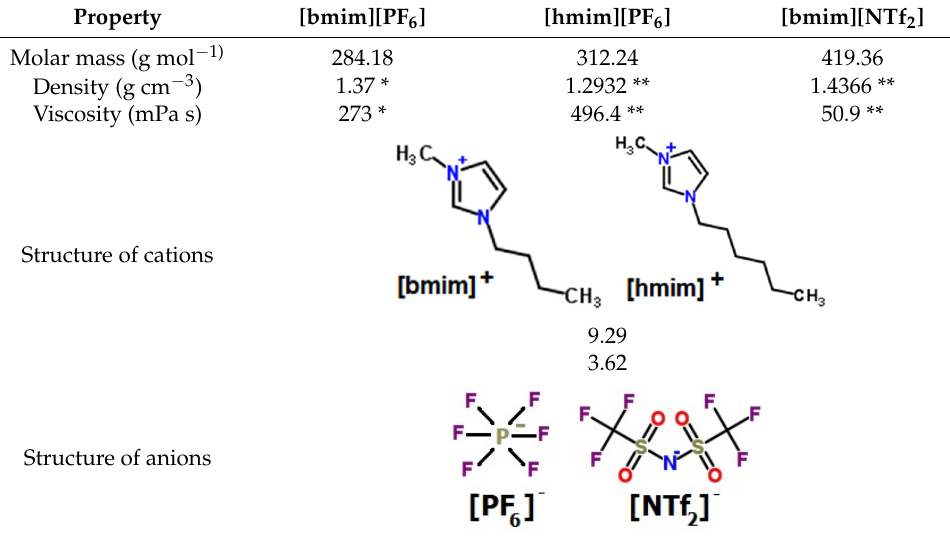
Table 1. Basic data and structure of the applied ILs. Property